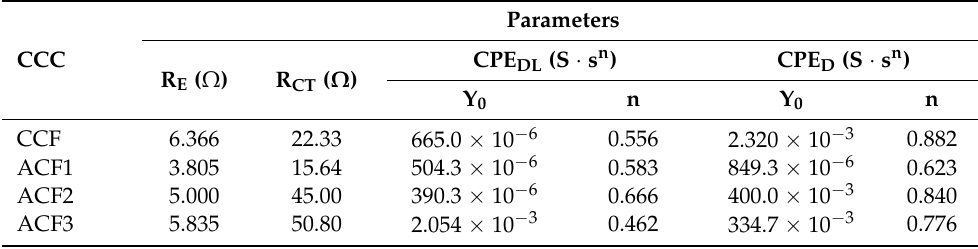
Table 3. Equivalent circuit parameters for the fitted electrochemical impedance spectroscopy (EIS) data with a Pt/Seawater/(Ag/AgCl)/CCC